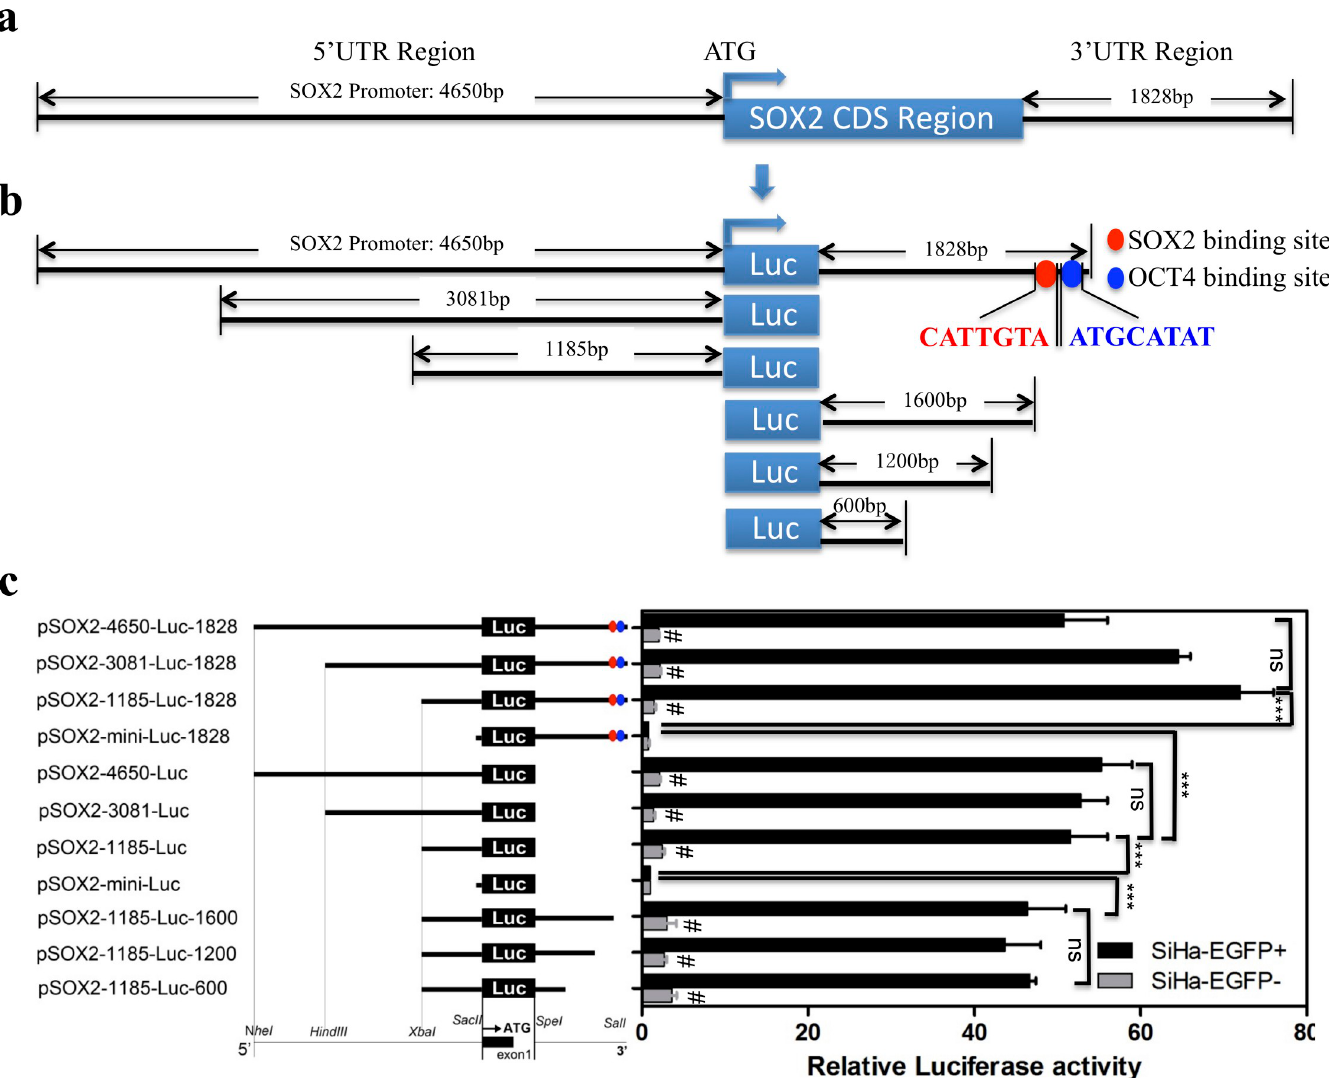
Fig 2. An integrated analysis of the SOX2 transcriptional element in cervical CSCs. (a and b) The diagram of full promoter of SOX2 and the deletions containing the possible cis -acting elements and the SOX2 and OCT4 binding sites (c) The full promoter of SOX2 (pSOX2-4650-luc-1828) and deletions were constructed and luciferase activity relative to Renilla control was measured in SiHa-EGFP+ and SiHa-EGFP- cells. The transcriptional activity of pSOX2-mini-luc served as the negative control and the SOX2 transcriptional activity was expressed relative to pSOX2-mini-luc. Data is presented as the mean ± SD of experiments in triplicate and statistically analyzed with student’s t -test. The symbol # represent SiHa-EGFP+ vs SiHa-EGFP- and p < 0.05, ��� represents a p value of < 0.001 and ns indicates no statistical difference.